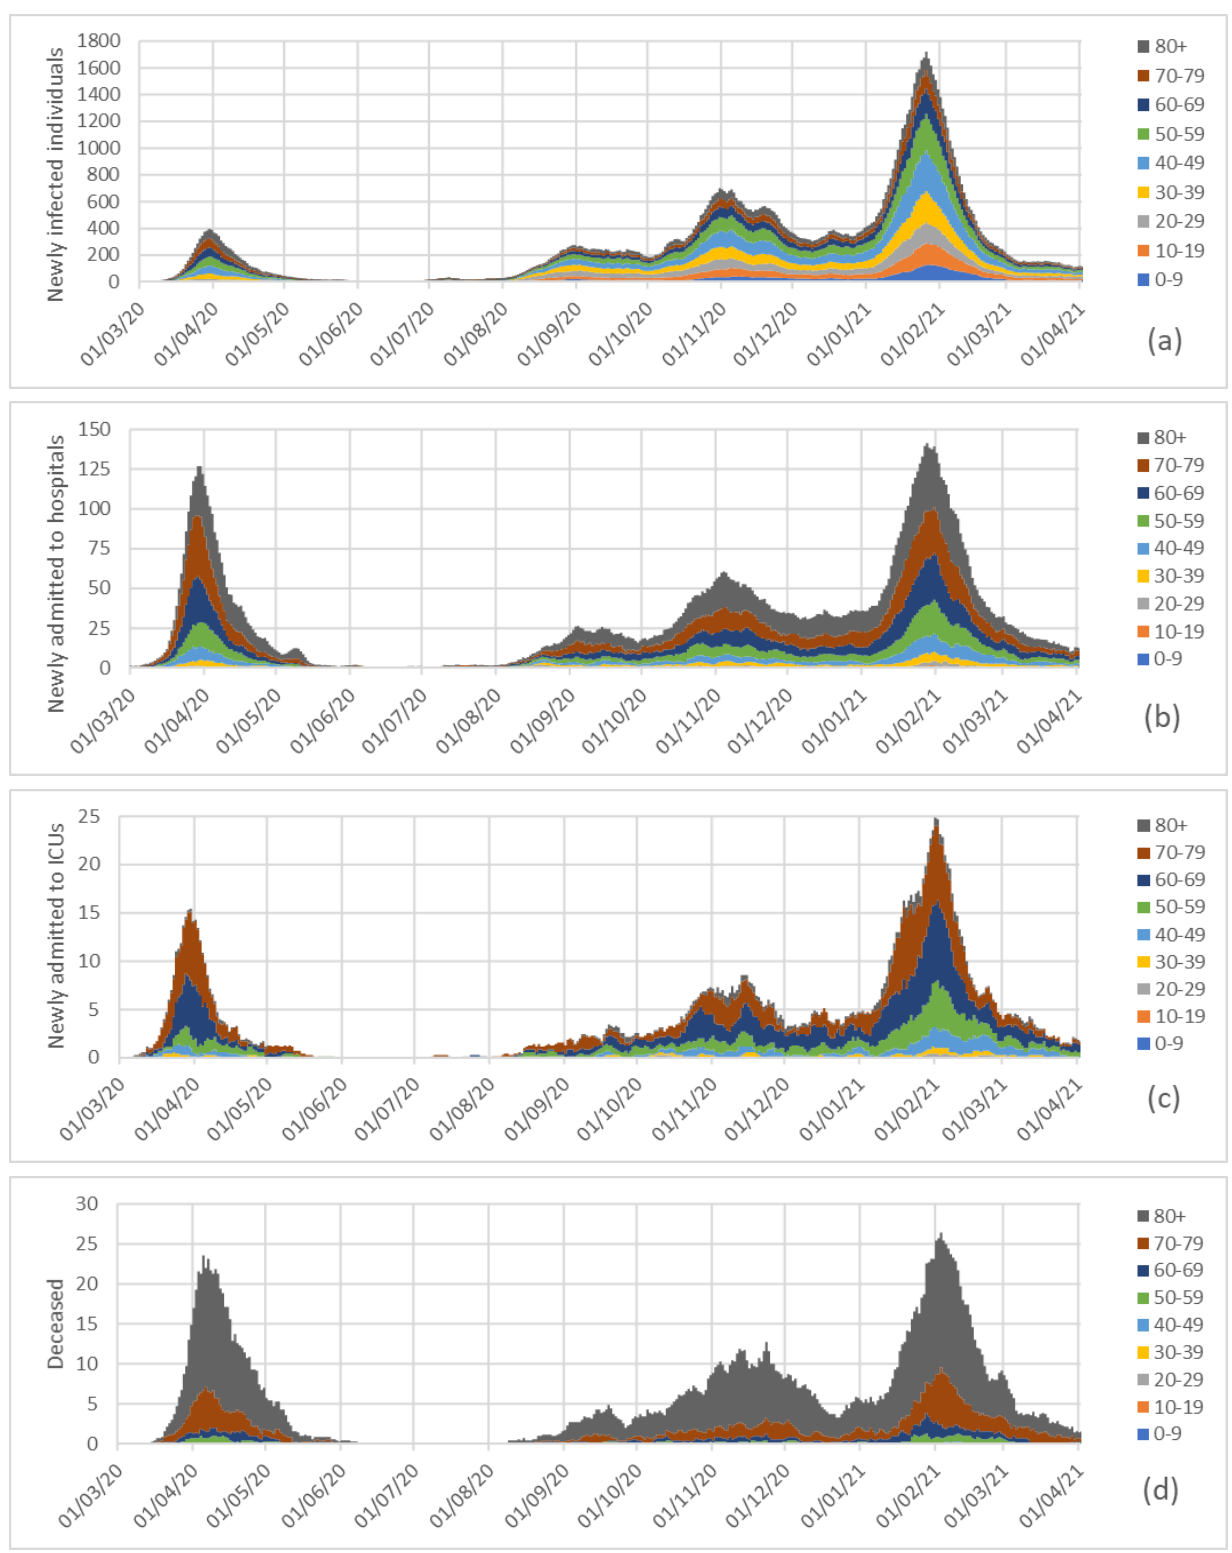
Figure 2. Newly infected individuals ( a ), admissions to hospitals ( b ), admissions to intensive care units ( c ) and deceased ( d ) in Galicia since the beginning of the pandemic, by considering age groups and means of the seven previous days.